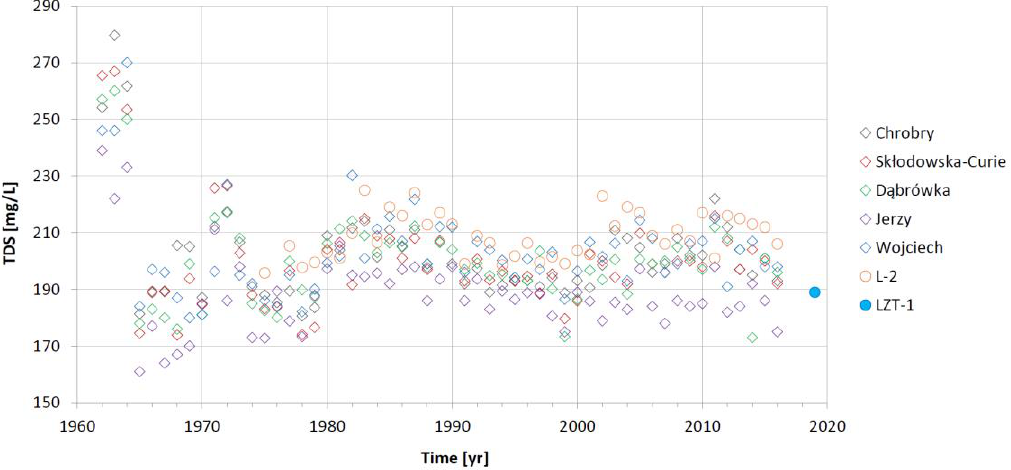
Figure 6. Temporal variation in TDS content in waters from particular intakes (based on [43,44,79] updated); symbols: diamond—spring, and circle—borehole.